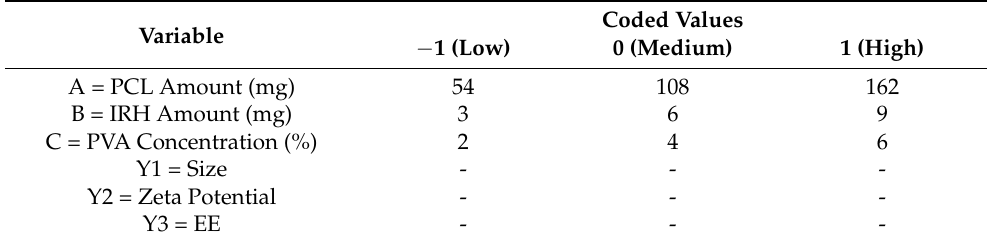
Table 1. Box–Behnken coded and actual values.